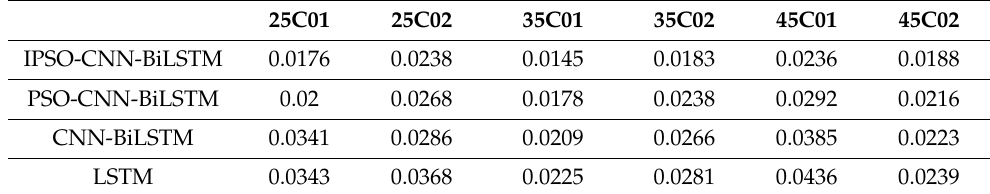
Table 7. The RMSE of different models for LIBs.